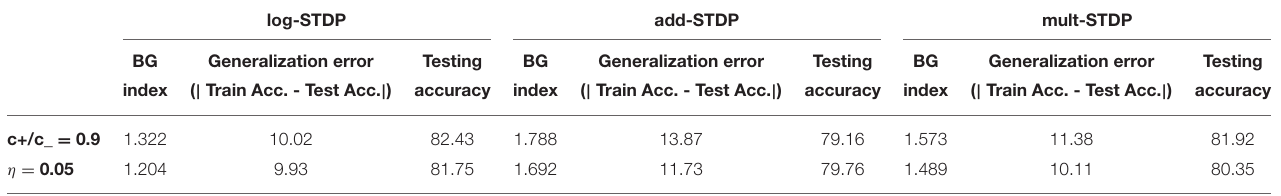
The values noted as generalization error in the table is computed as: (